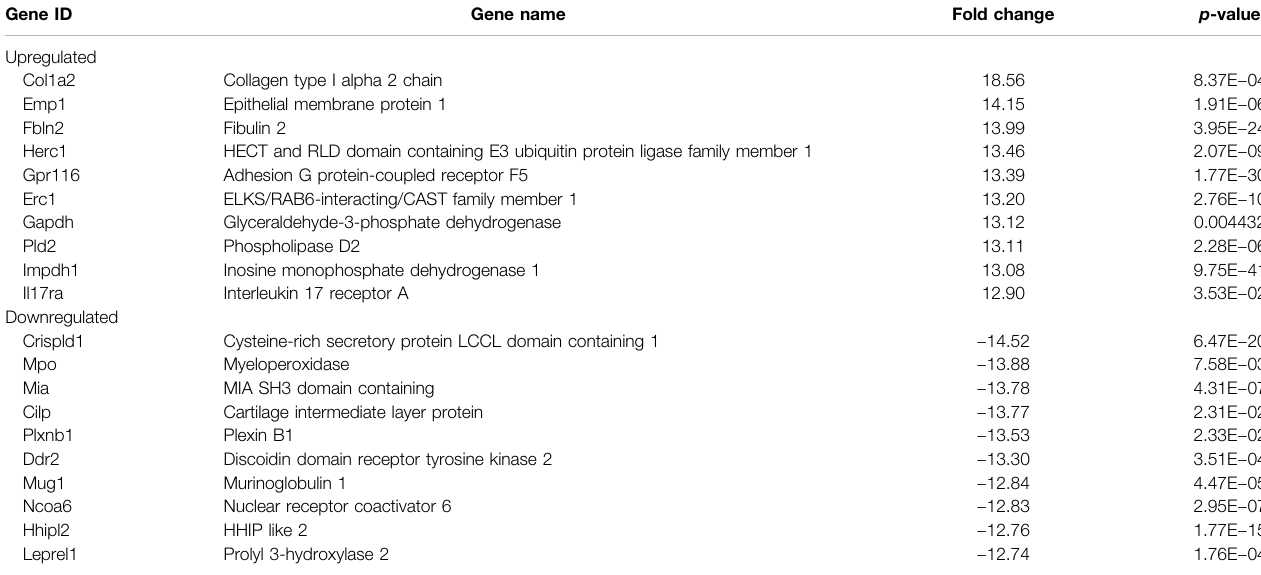
TABLE 2 | Top 10 upregulated and top 10 downregulated genes in the monosodium iodoacetate- (MIA-) treated rats vs. the saline-treated rats. Gene ID